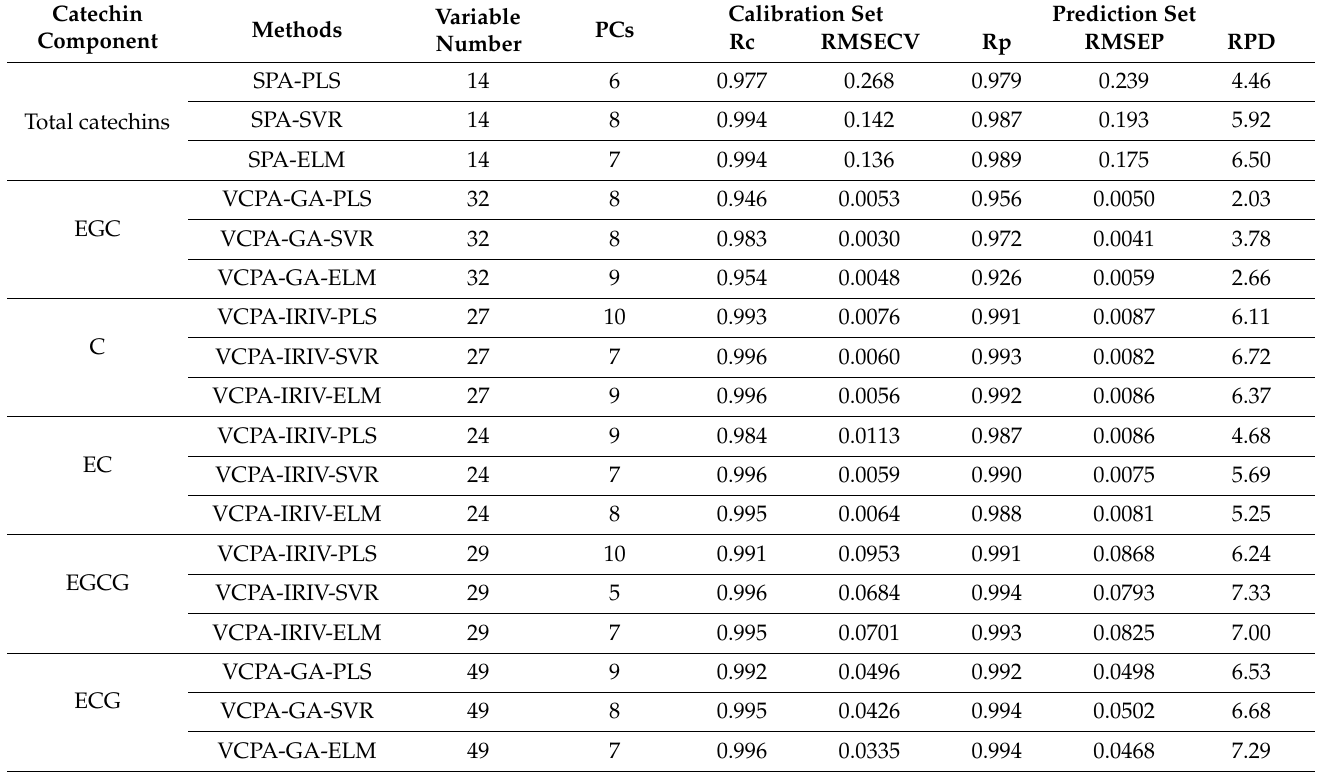
Table 3. Catechin content prediction results from different